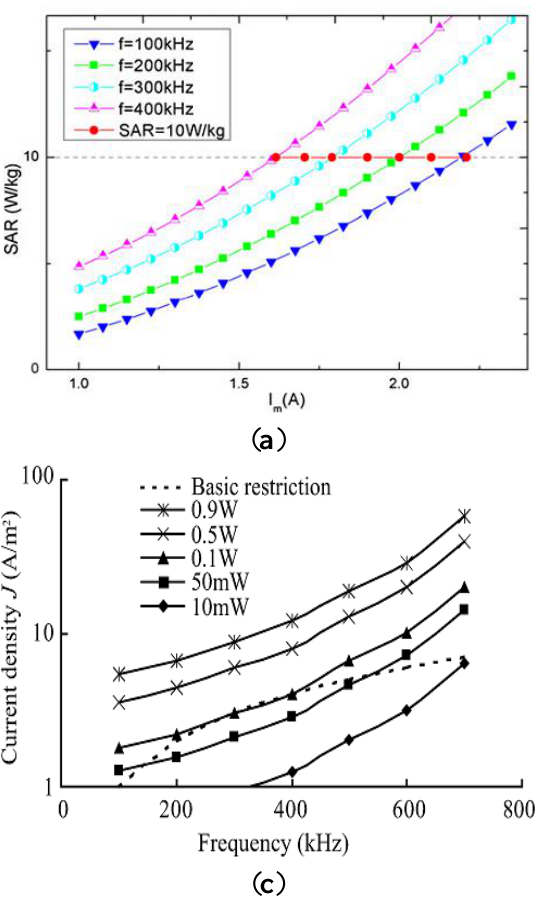
Figure 6. Variation of safety parameters with the design constants: ( a ) SAR with respect to frequency and TC current [12]; ( b ) Current density (J) with respect to frequency and TC current [12]; ( c ) Current density with respect to frequency and received power [75]; ( d ) temperature of RC with respect to wire strands